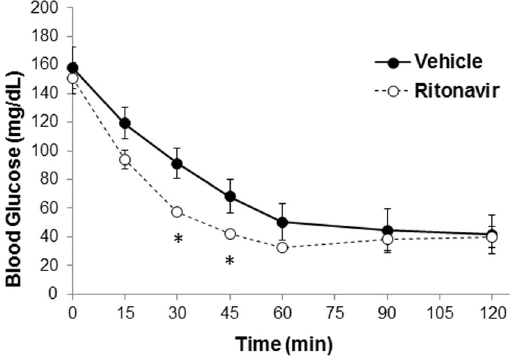
Figure 4. Effects of Chronic Ritonavir on Insulin Sensitivity in TG9 Mice. Insulin tolerance tests were performed following a 5 hr fast on male TG9 mice that had been treated with ritonavir or vehicle for 3 weeks as described in Methods. (n = 4–6/group). * p < 0.05 vs. Veh.